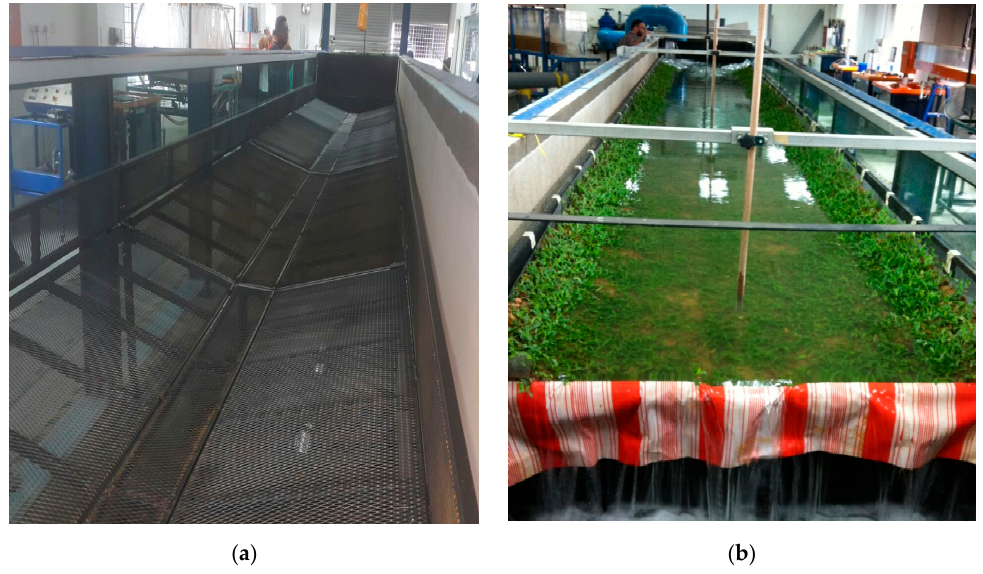
Figure 1. The trapezoidal channel model: ( a ) perforated steel sheets with steel frame ( b ); the channel with check dams during operation.